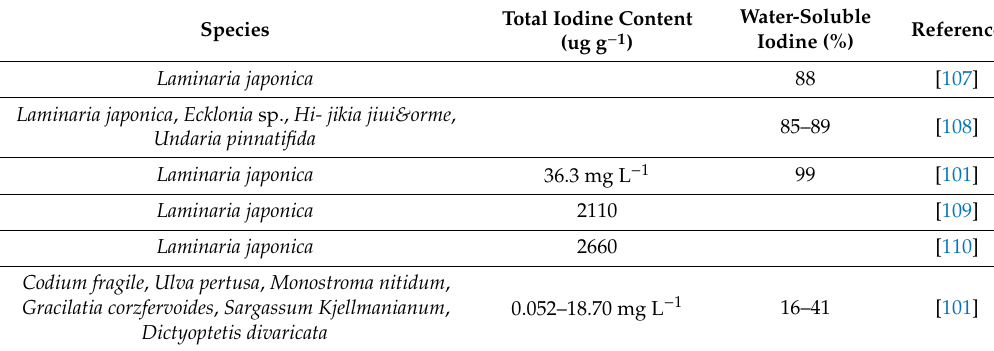
Table 1. Iodine content in marine